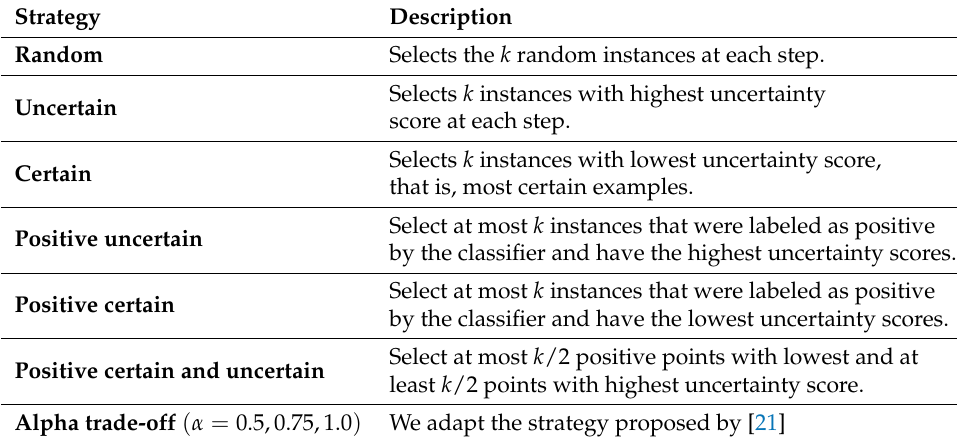
Table 1. Active learning and recommendation